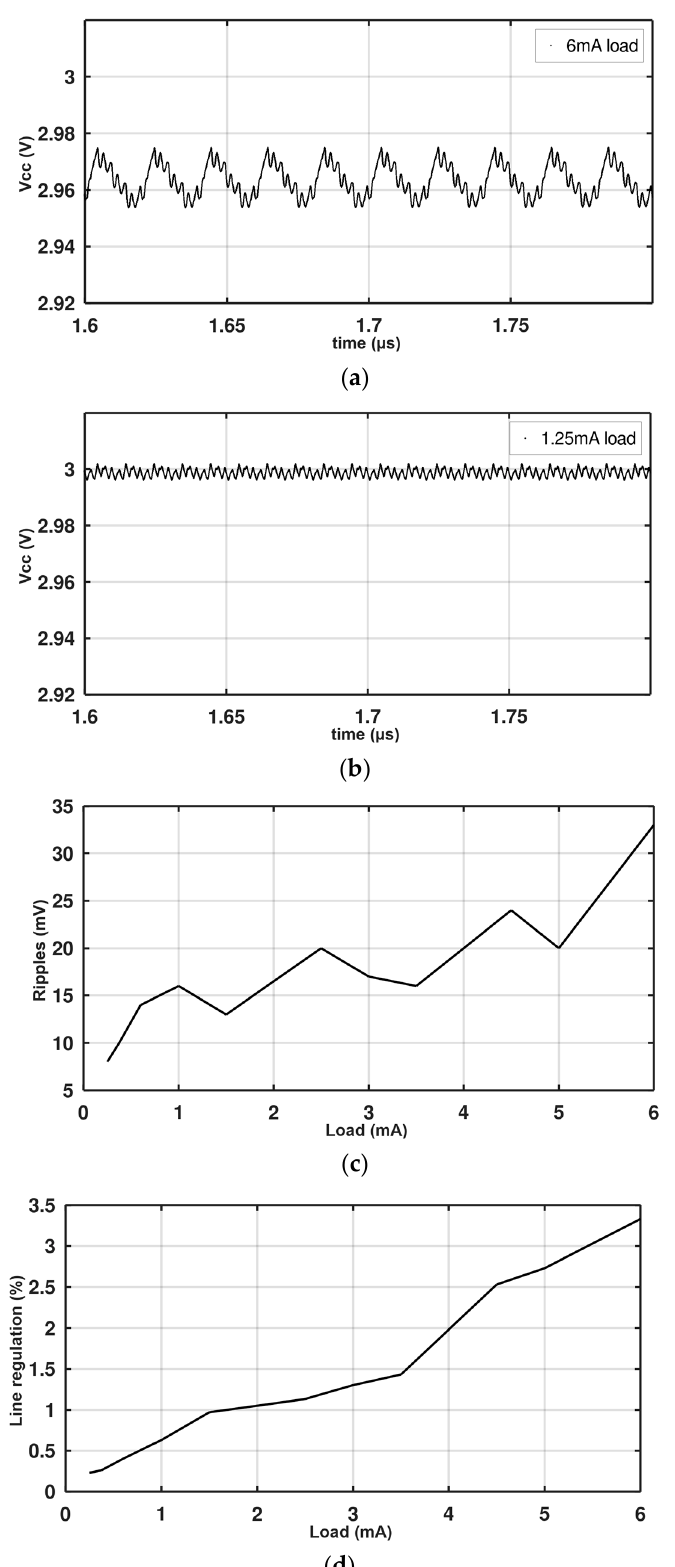
Figure 8. The ripples of the output at different load levels: ( a ) 6 mA load; ( b ) 1.25 mA load; ( c ) ripples vs. load; ( d ) line regulation vs. load.